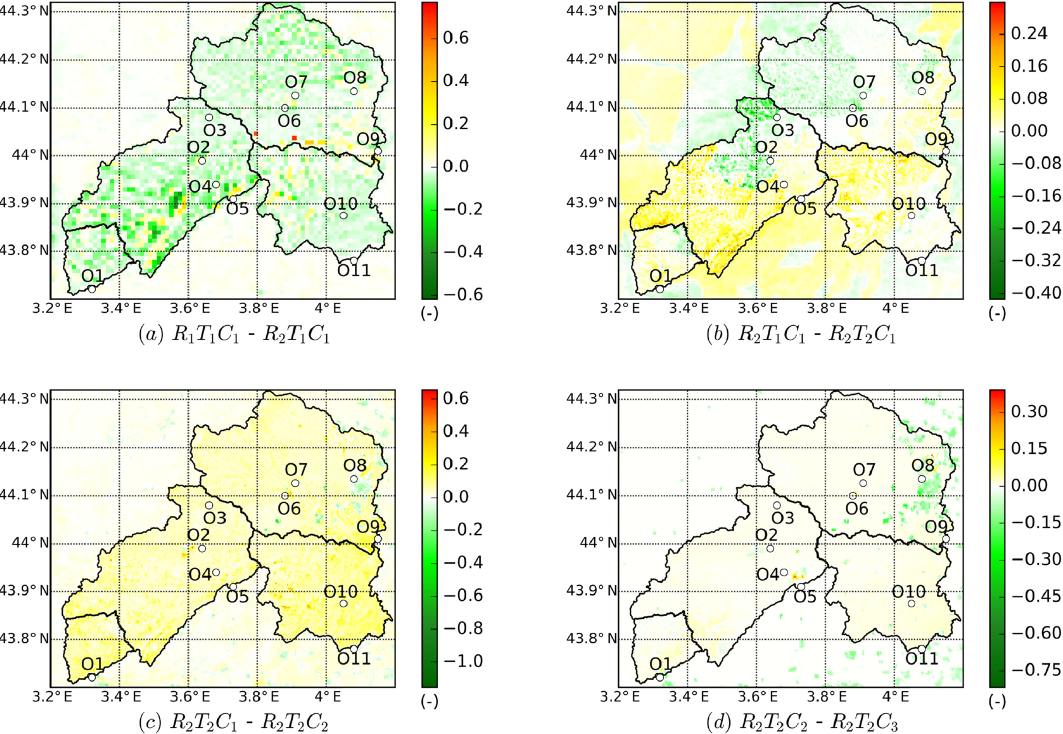
Figure 5. Mean differences in the ratios of the runoff amounts to the rainfall amounts (without units) (a) between R 1 T 1 C 1 and R 2 T 1 C 1 , (b) between R 2 T 1 C 1 and R 2 T 2 C 1 , (c) between R 2 T 2 C 1 and R 2 T 2 C 2 , and (d) between R 2 T 2 C 2 and R 2 T 2 C 3 . Note that the range of the colour scale is not the same for the various panels; however, in red–yellow, the differences are always positive, and in green, they are always negative.